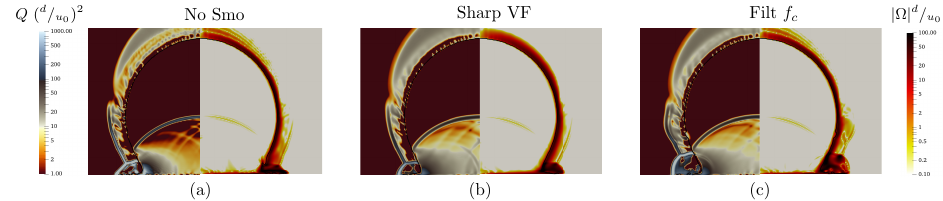
Figure 5. Q criterion and vorticity distribution at the droplet at 70 ns for the different smoothig strategies: ( a ) No. Smo.; ( b ) Sharp. V.F.; ( c ) Filtering f c . Black line represents the iso-line of α =